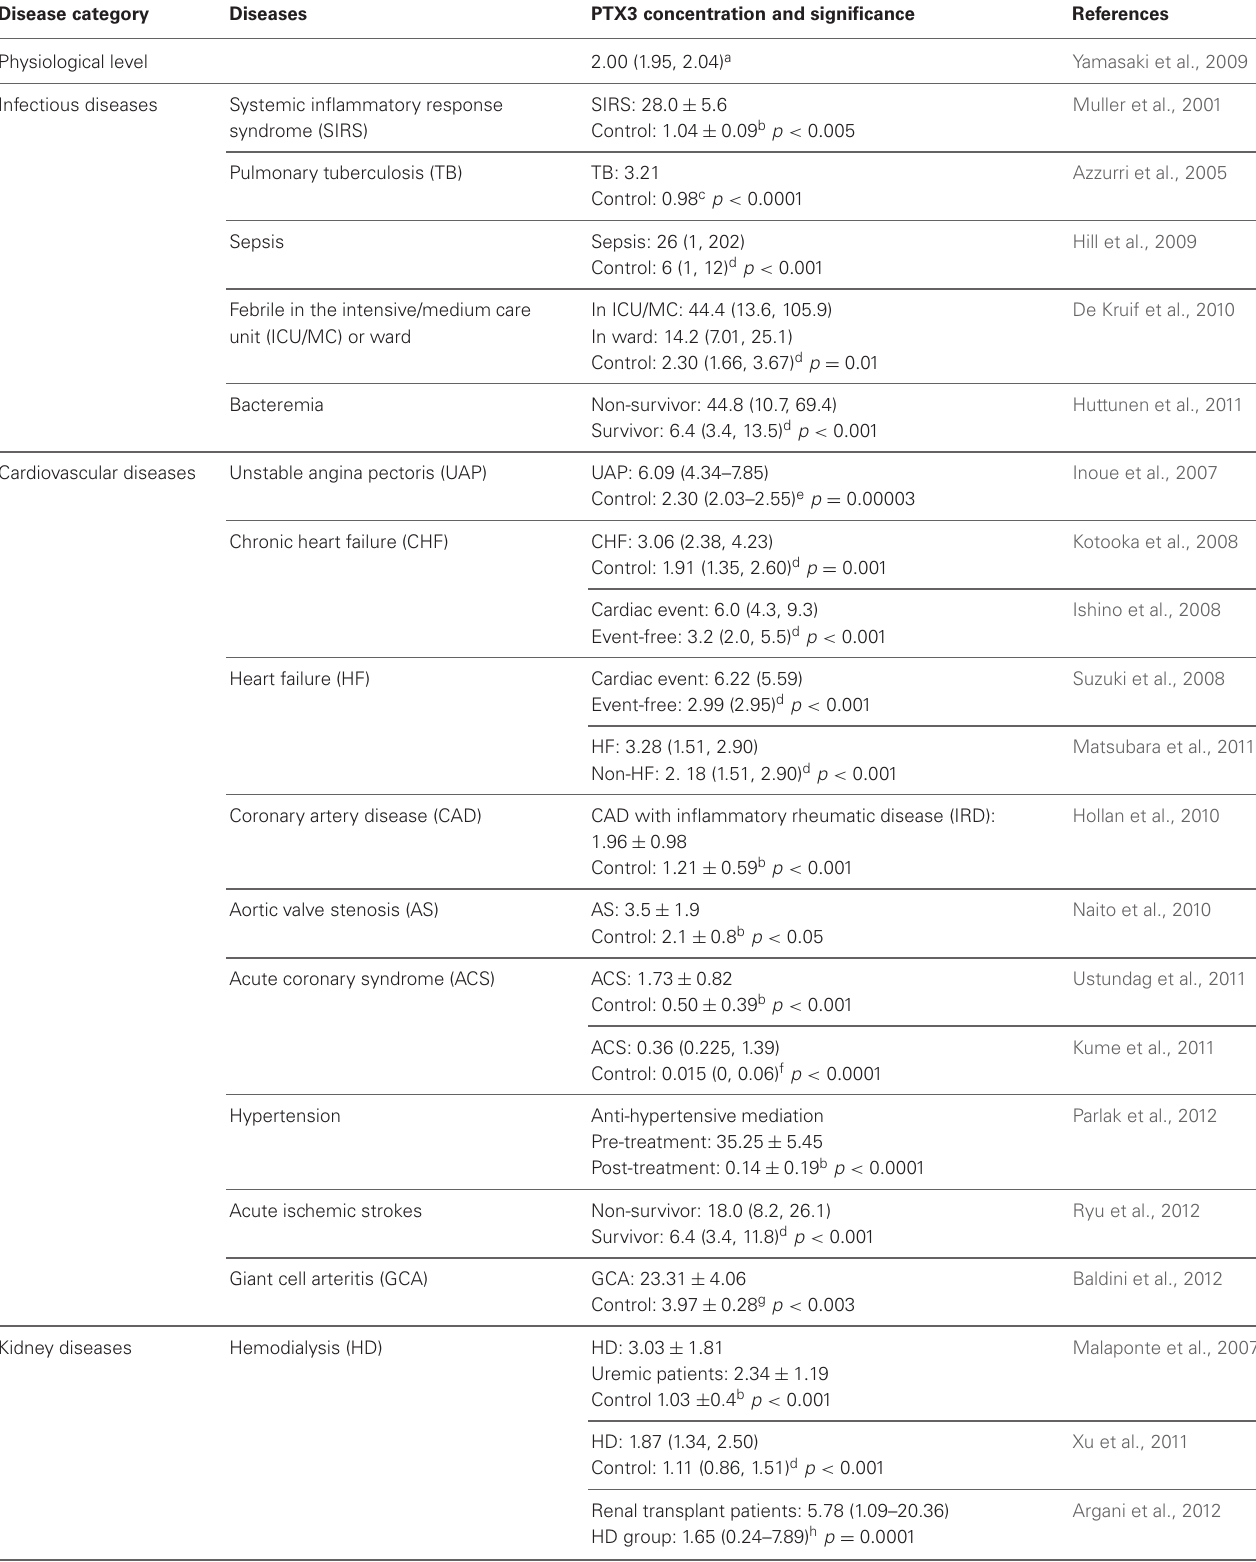
Table 1 | Circulating PTX3 levels measurements in clinical